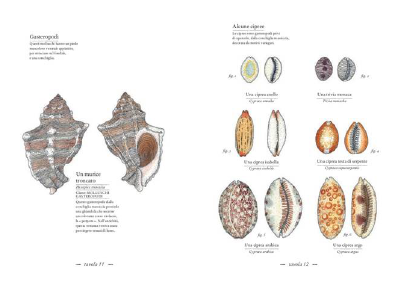
Figure 10. Tchoukriel J.; Aladjidi V., Inventario illustrato del mare ; Ippocampo, Italia 2011, [10].